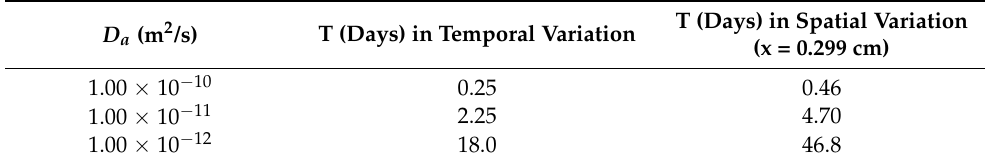
Table 5. Steady-state time in temporal and spatial variation with different D a values. D a (m 2